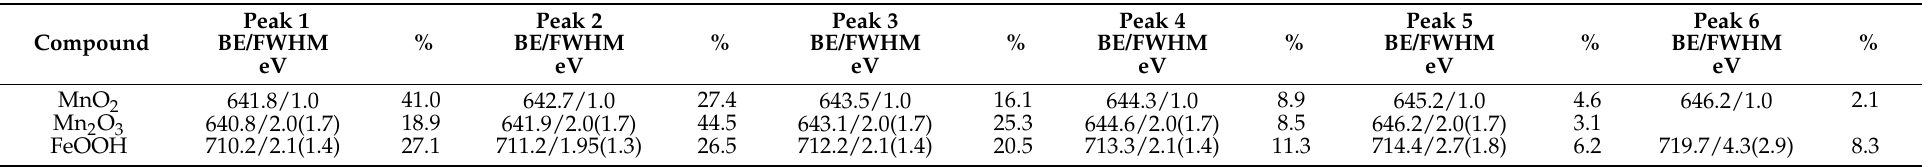
Table 1. Mn 2p 3/2 and Fe 2p 3/2 spectral fitting parameters: binding energy (eV), percentage of total area, and spectral component separation (eV) for given FWHM values (eV).